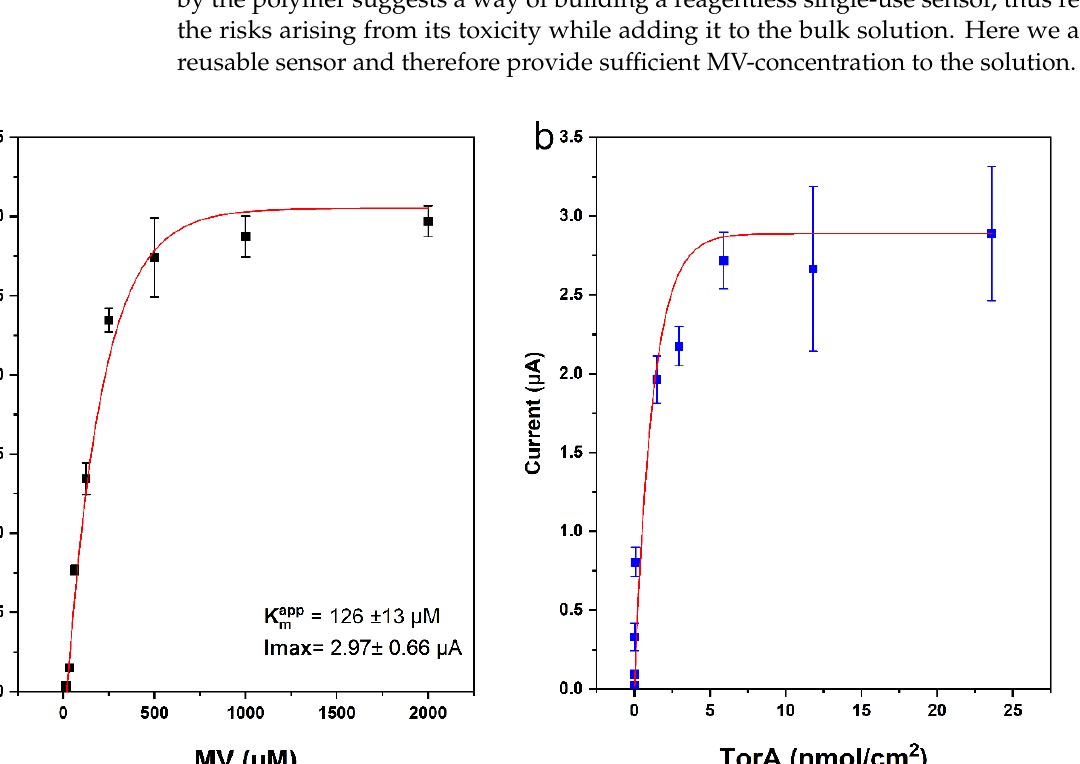
Figure 6. pH dependency of the response of the TorA biosensor to (red) mediator and (black) TMAO. TorA (5.9 nmol/cm 2 ) GOD 10 U, Cat 1000 U, 3 mM glucose, PVA 3%. Measurements were performed in Sörensen phosphate buffer with different pH values (5, 6, 7 and 8) and containing 3 mM glucose. Solutions used to perform experiments at pH 4 and pH 9 were obtained by adding a solution of HCl (100 mM) and NaOH (100 mM), respectively, to the previous Sörensen phosphate buffer (67 mM) containing 1 M KCl (n = 9, 3 electrodes) .